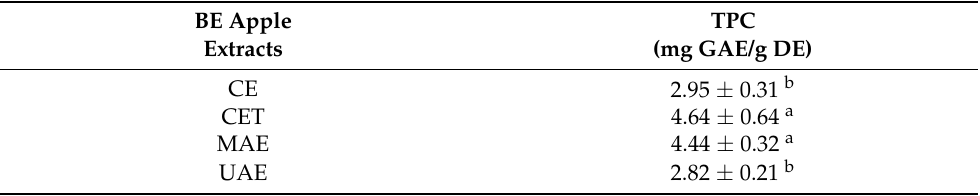
Table 1. The Total Phenolic Content (TPC) in ‘Bravo de Esmolfe’ apple extracts. Values are represented by the average ± standard deviation. Different letters in row (a, b) mean significant differences between extraction methodologies, determined by Tukey’s test ( p <